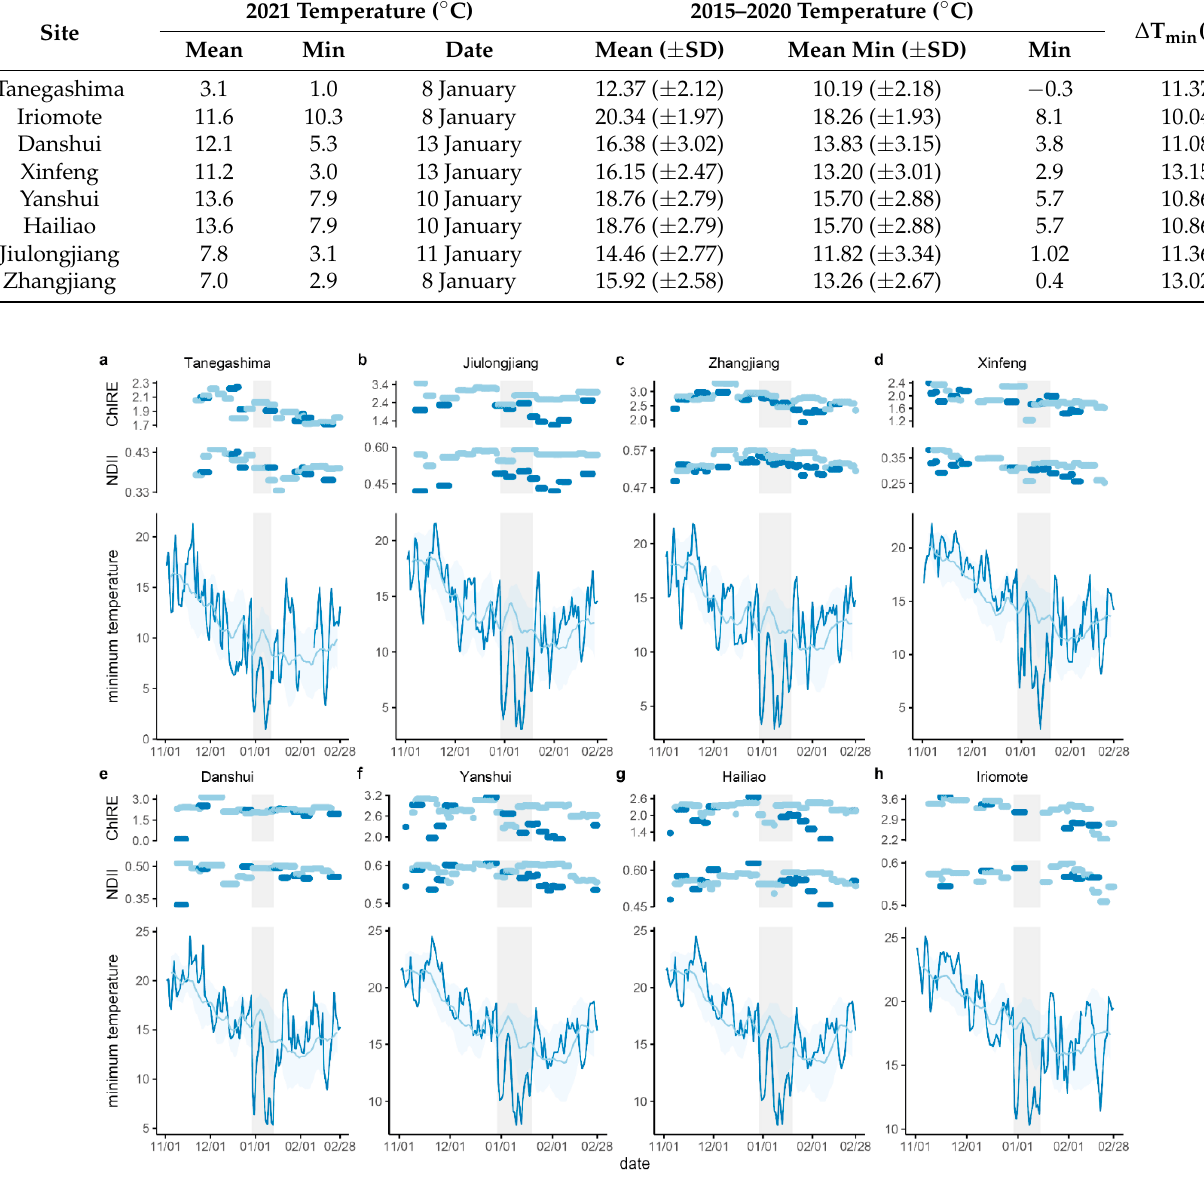
Figure 2. Chronologies of the chlorophyll red-edge index (ChlRE), normalized difference infrared index (NDII), and minimum temperature ( ◦ C) from November 1 to March 1 for 2020–2021 winter (dark blue) and its baseline over 2015–2020 (light blue line) along with its standard variation (SD, light blue ribbon). The light grey bands depict the 2021 cold wave in the eight sites based on the three standard deviation threshold from the mean temperature. The ChlRE and NDII measured in 2015–2020 (light blue) are based on a 15-day moving maximum whereas the 2021 ChlRE and NDII are computed over a 7-day window. The temperature baseline is based on a 7-day moving average. The sites ( a – h ) are arranged from the lowest to the highest mean